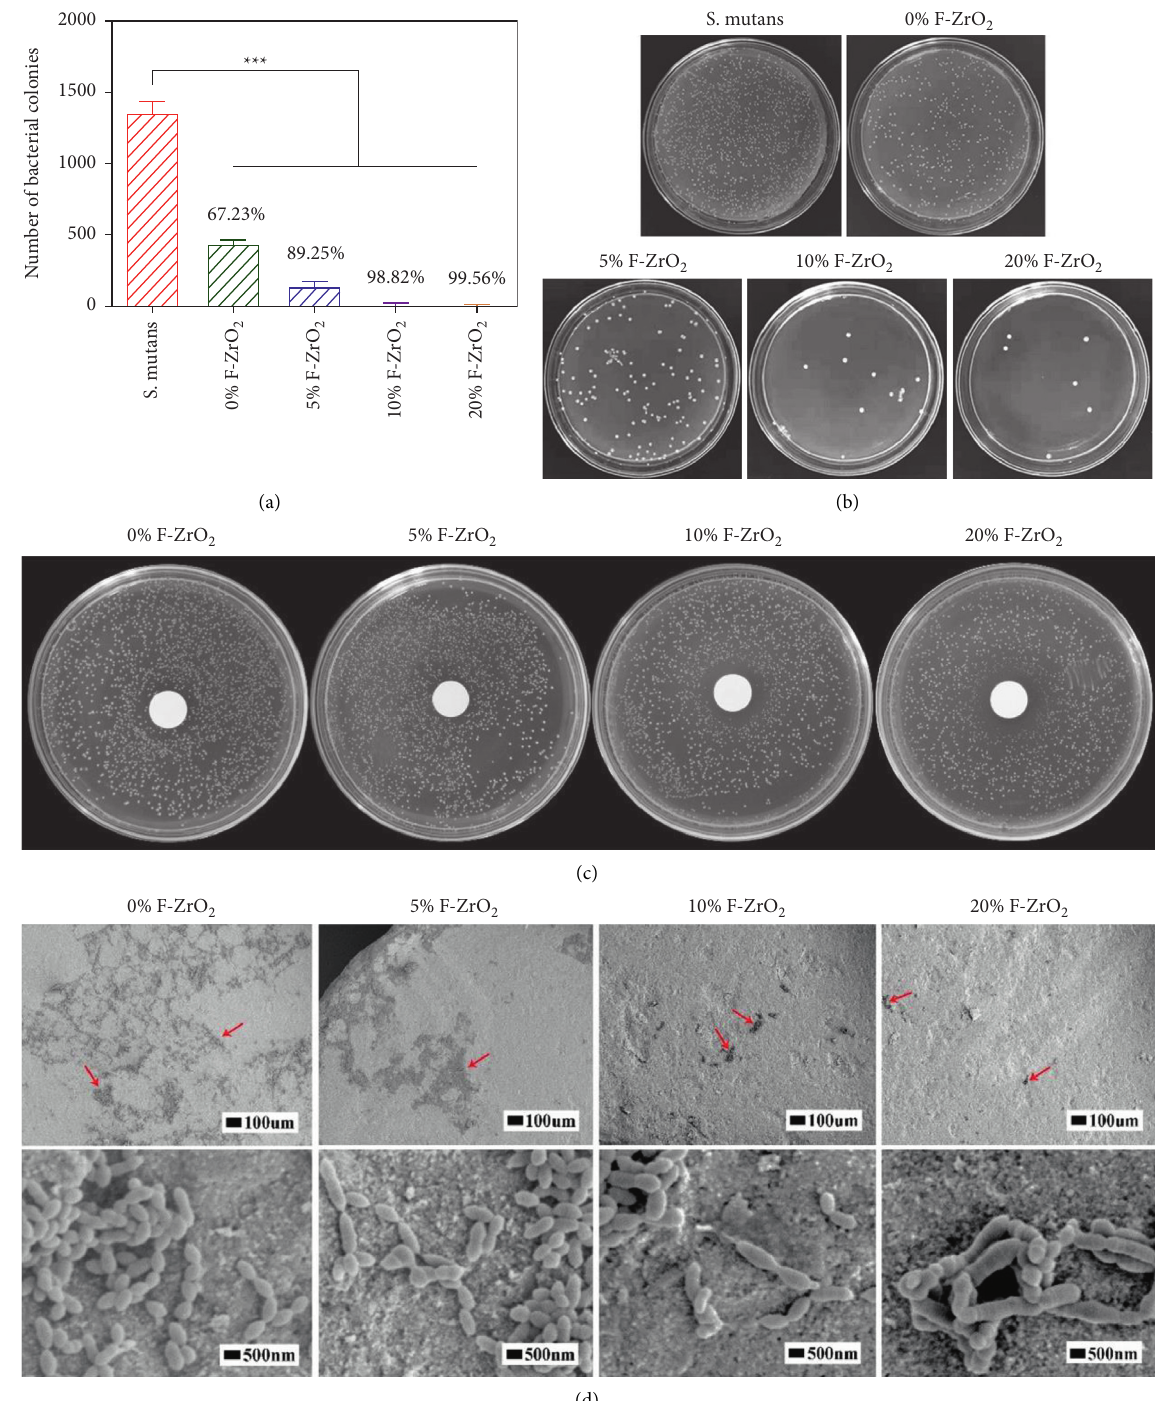
Figure 13: The results of antibacterial property of F-ZrO 2 powders. (a) Numbers of bacterial colonies and the antibacterial rates of different groups of F-ZrO 2 powders in CFUs counting. (b) Images of colonies of S. mutans after culturing with F-ZrO 2 powders for 24 hours. (c) Images of the area of inhibition zones in the agar diffusion test (ADT). (d) SEM images of S. mutans on the specimens of F-ZrO 2 disks (the red arrows differentiate the bacteria plaques on the surfaces of specimens)